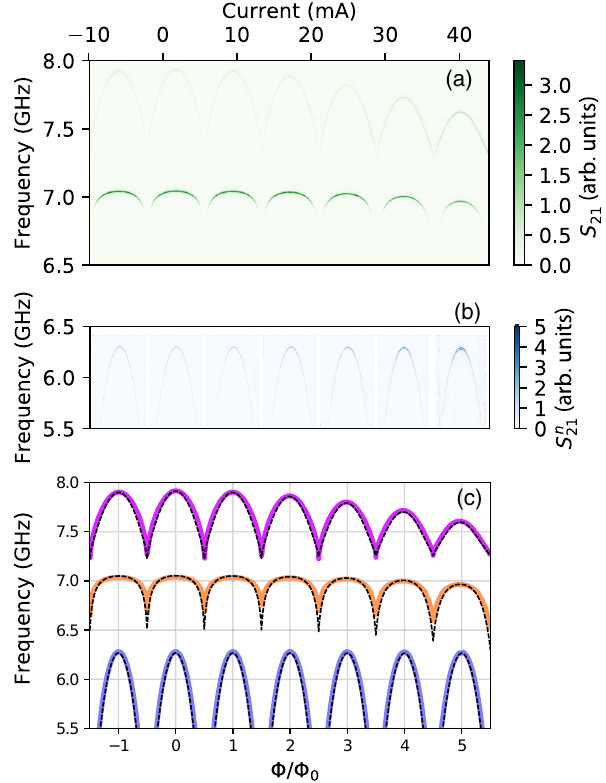
FIG. 8. (a) Single-tone transmission S 21 measurements in arbitrary units (arb. units) as function of driving frequency and flux (coil current). (b) Two-tone measurement, where the corre- sponding transmission S n 21 is normalized by its value without second tone. (c) Extracted resonance frequencies of qubit ω 0 q (blue), lower polariton ¯ ω (orange), and upper polariton ¯ ω l u (purple) as a function of the applied flux Φ = Φ 0 . The dashed black lines correspond to the theoretical predictions from the numerical diagonalization of the circuit model in Sec. F